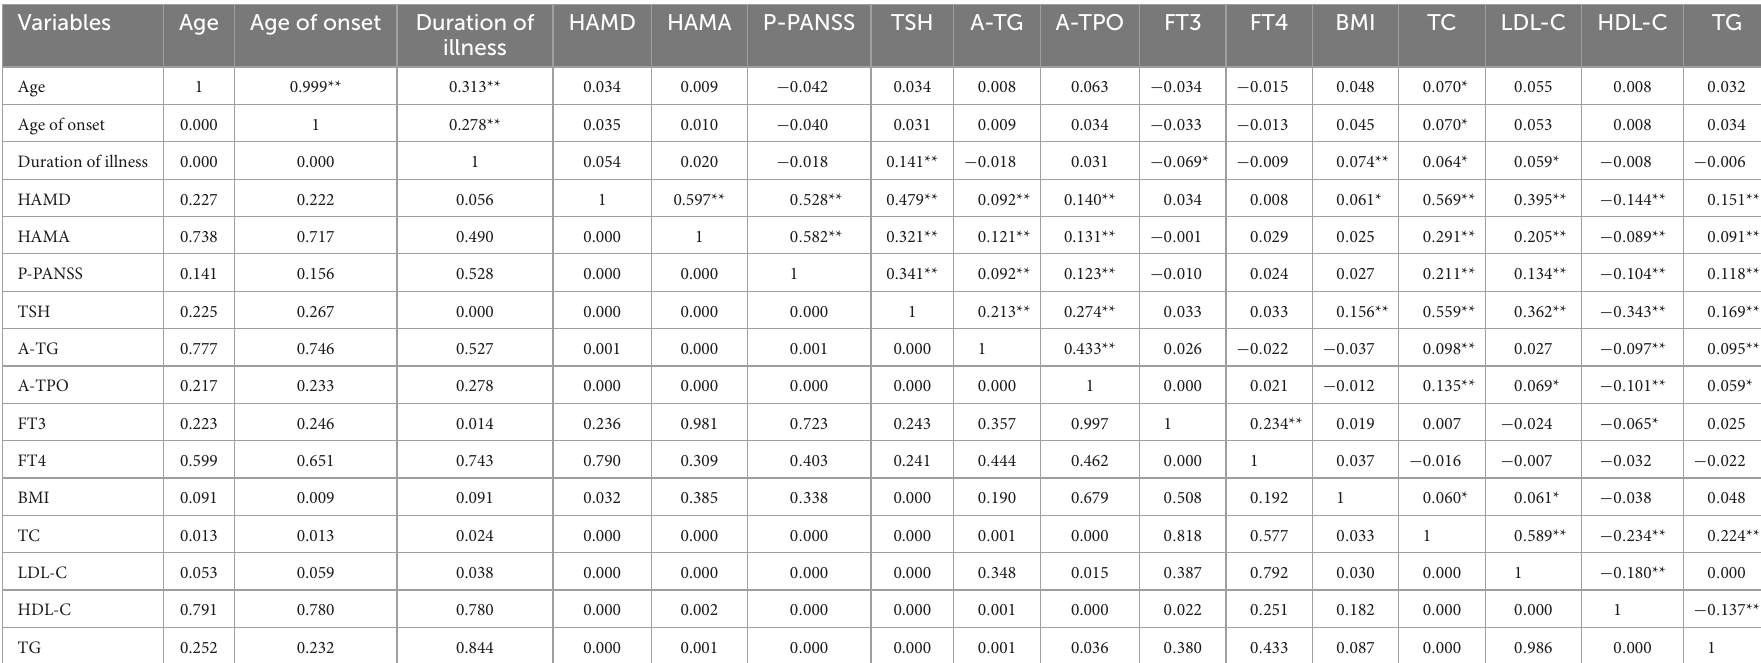
TABLE 2 Inter-relationships between demographic and clinical variables in young adult patients with FEDN